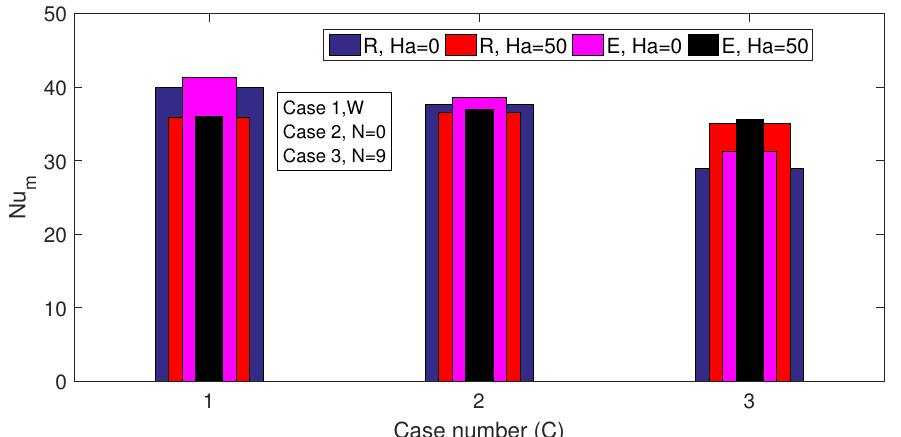
Figure 14. Comparison of different cases (MGF, PPP and elastic wall) in terms of thermal performance